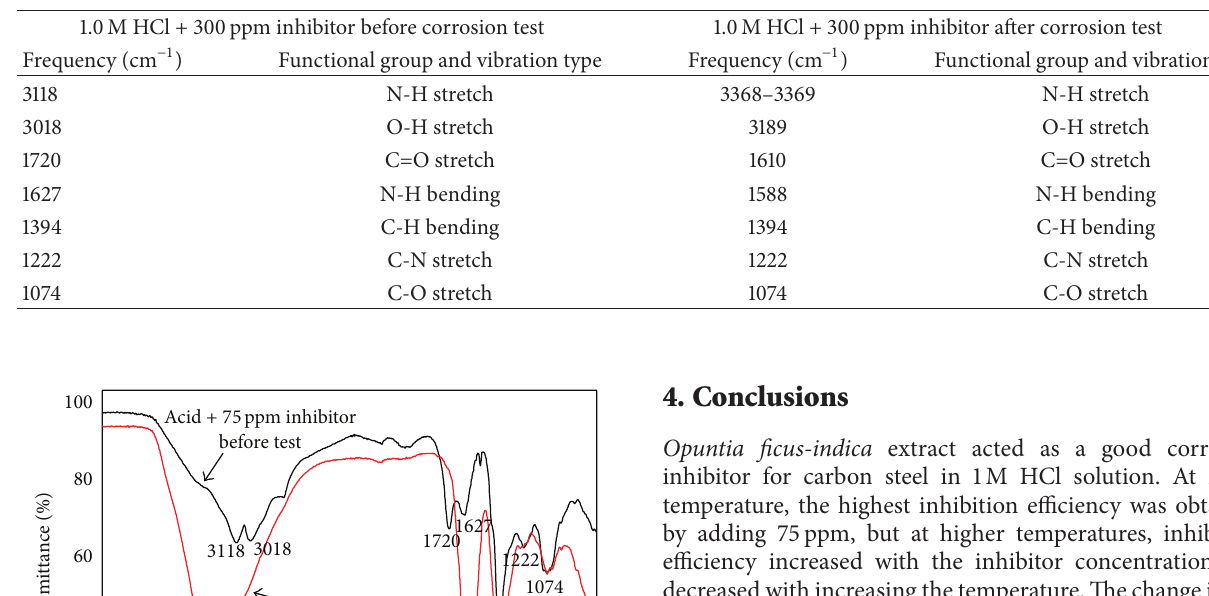
Table 4: Characteristic peaks obtained from FT-IR spectra for 1.0 M HCl + Opuntia ficus-indica solution before and after corrosion test.